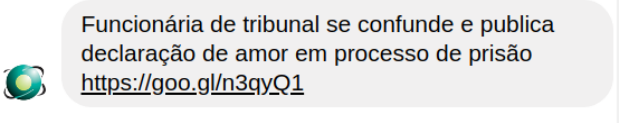
Fig. 18. BOL chatbot’s simple message with a news story. Translation: Court employee publishes love declaration in sentence of arrest by mistake